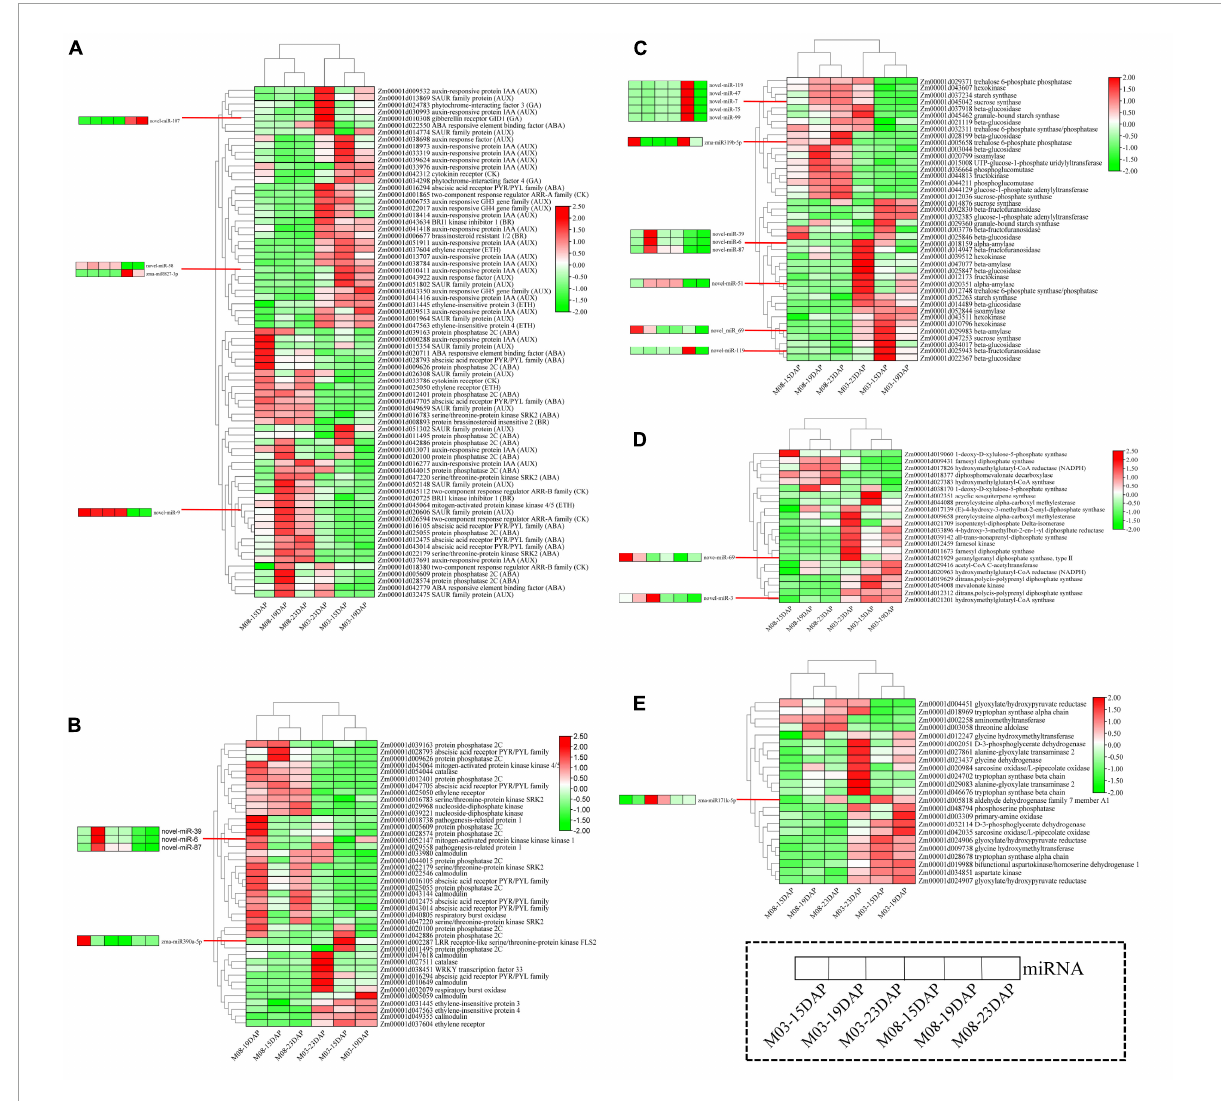
FIGURE6 Heatmaps of DEGs and corresponding DEMIs in important pathways. (A) Plant hormone signal transduction. (B) MAPK signaling pathway. (C) Starch and sucrose metabolism. (D) Terpenoid backbone biosynthesis. (E) Glycine, serine, and threonine